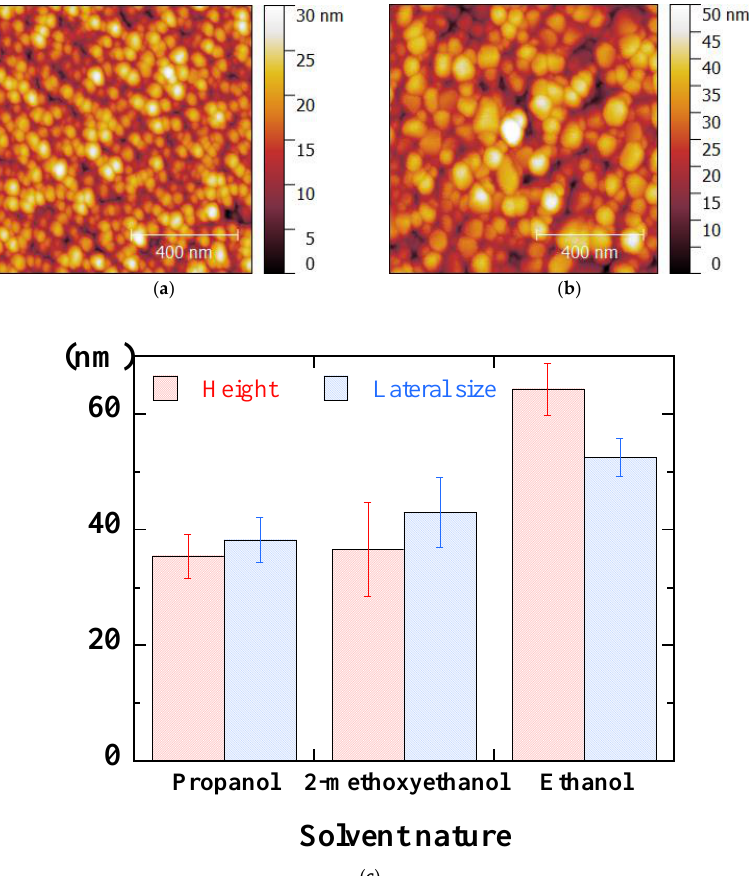
Figure 16. AFM micrographs of sol-gel spin-coated ZnO thin films deposited with propanol ( a ) and ethanol ( b ) and AFM results of ZnO thin films deposited with different solvents ( c ).